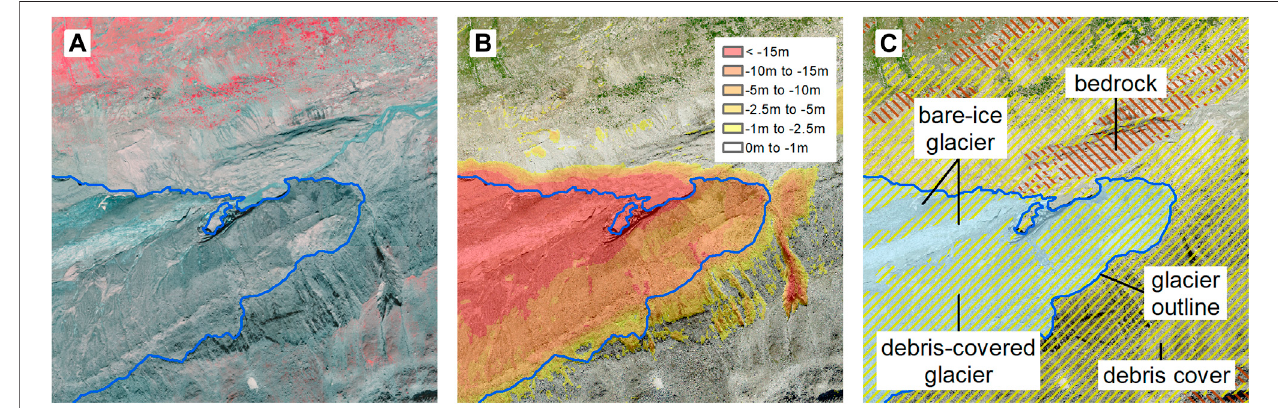
FIGURE3| Thehighly debris-covered tongue ofUnteraargletscher intheBernese Oberland asseenon thedigital aerial images and used formappingin3D-views byswisstopotopographers.Thecombinationof (A) infraredand (B) truecolor(RGB)combinedwithswissALTI 3D elevationdifferences(yellowtoredcolors)resultsin (C) swissTLM 3D object classes. The blue line in all panels indicates the swissTLM 3D object class “ glacier. ”